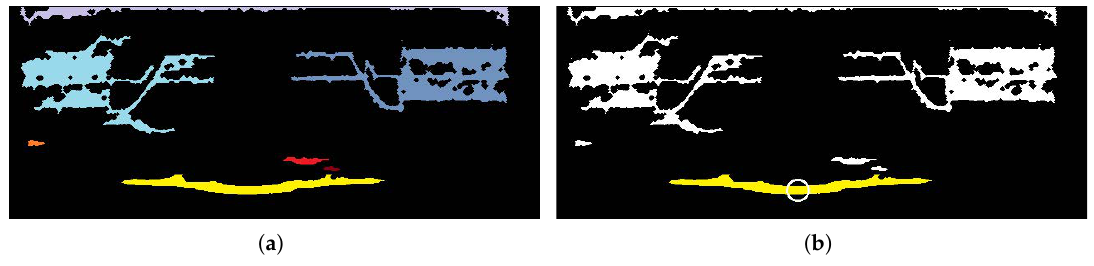
Figure 6. ( a ) Connected component labeling result (each colored marker involves discriminating objects); ( b ) result of object selection (circle indicates detected position).